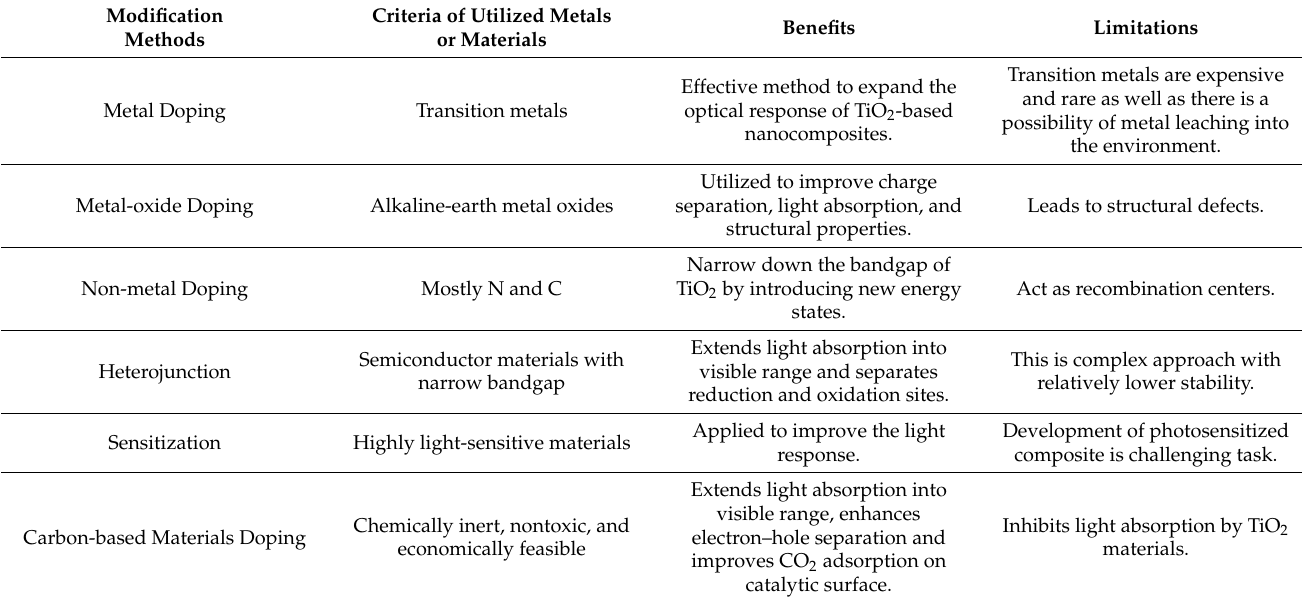
Figure 6. Modification methods used for improving the CO 2 photoreduction activity of TNTs. Table 3. Comparison of various modification methods utilized for improving photocatalytic activity of TNTs.